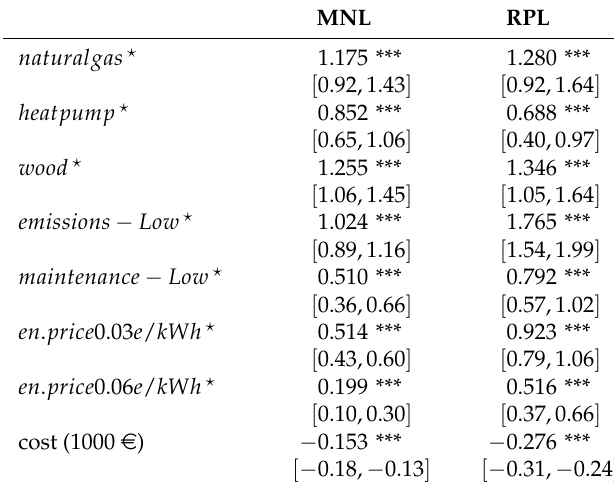
Table 4. DCE models’